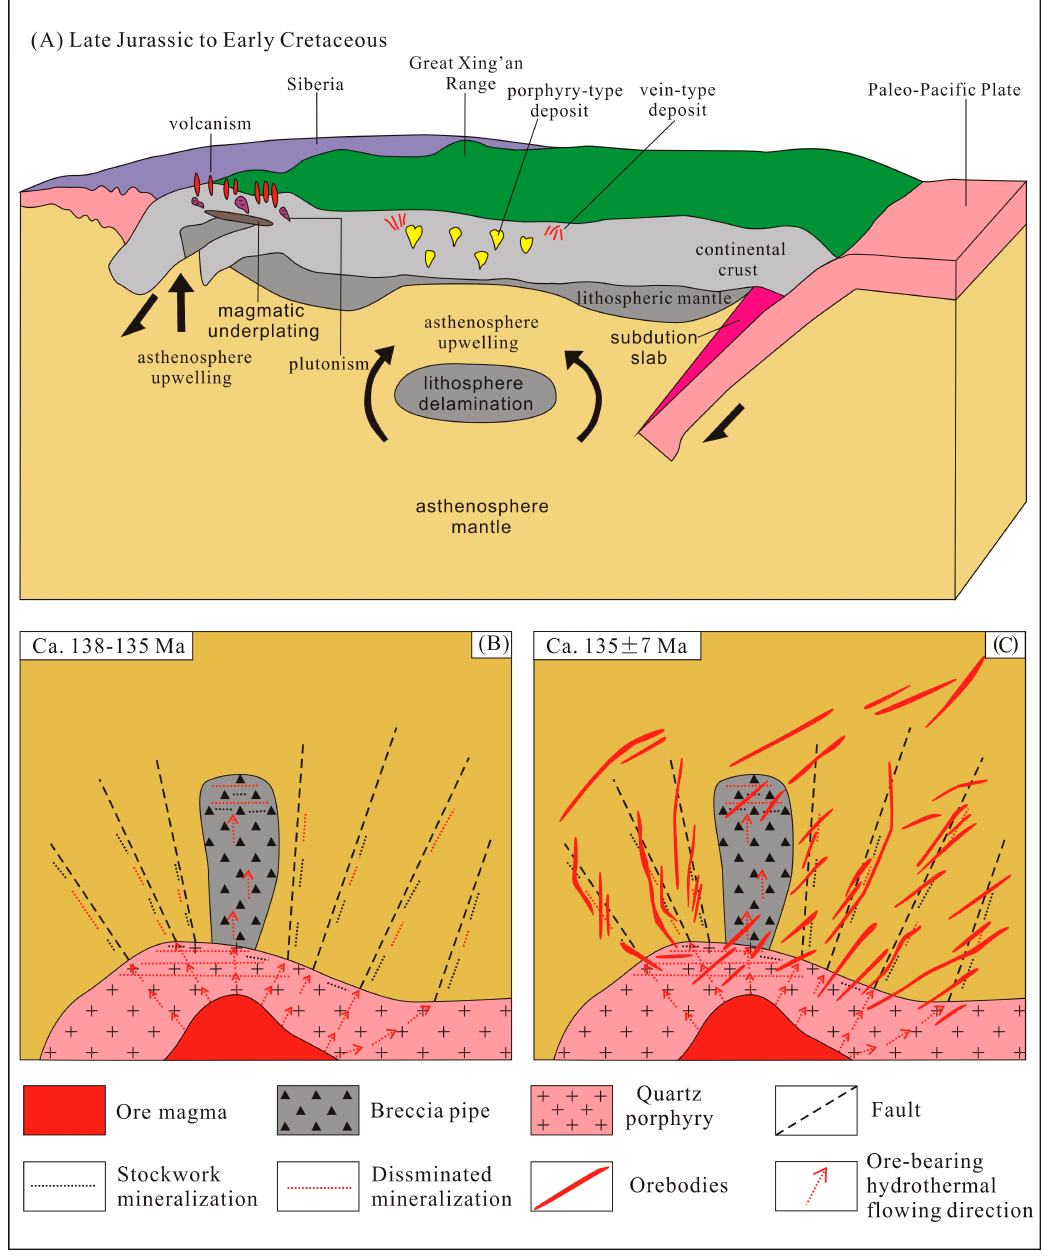
Figure 13. ( A ) Schematic model of the Late Jurassic to Early Cretaceous geodynamic evolution and associated ore deposits in the Great Xing’an Range. ( B ) Schematic model for the Weilasituo Sn-polymetallic deposit during 138–135 Ma. ( C ) Schematic model for the Weilasituo Sn-polymetallic deposit at 135 Ma.